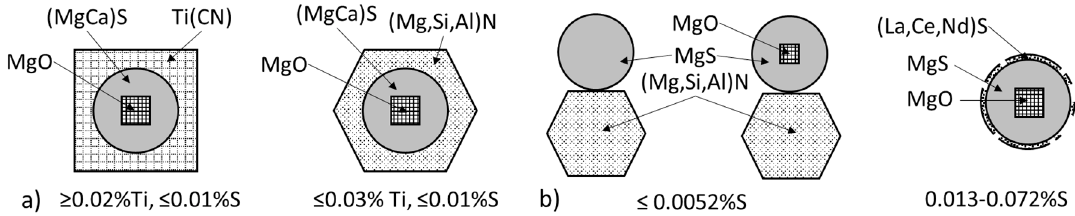
Figure 26. Schematic representation of the effect of titanium ( a ) and sulfur ( b ) in iron on the compounds serving as nuclei and on the nucleation sequence.